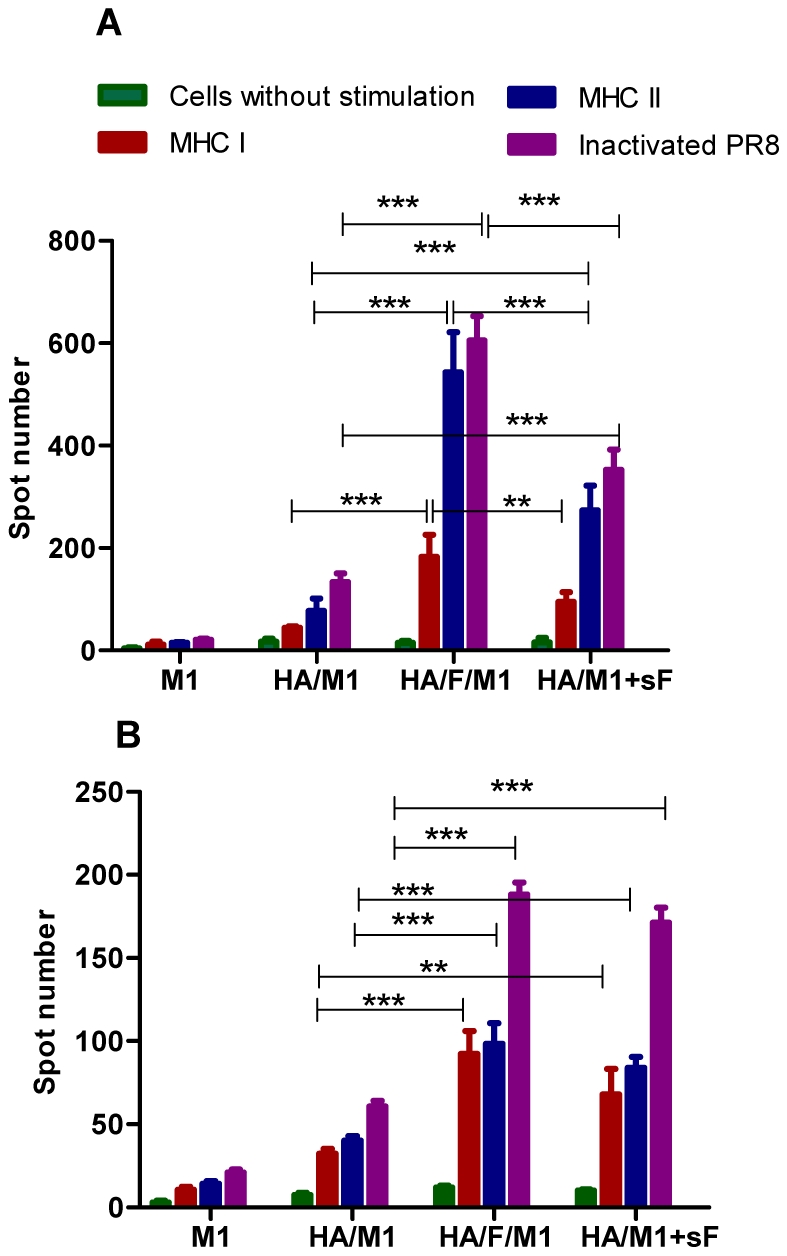
Cytokine secretion from immunized mouse splenocytes.ELIspot assays were used to detect the proliferation of antigen-specific CD4+ secreting INF-γ (A) or IL-4 (B) cells as described in “Materials and Methods”. Splenocytes were isolated from immunized mice 4 weeks after the boosting immunization and seeded into pre-coated Multiscreen plates (Millipore). Defined peptides (MHC I or MHC II) or inactivated PR8 viruses were added to stimulate antigen-specific T cell proliferation. Cytokine secreting clones were visualized by spot staining following the manufacturer's instruction. Representative data were mean ± S.D. of spot number in 1×106 splenocytes of six mice.